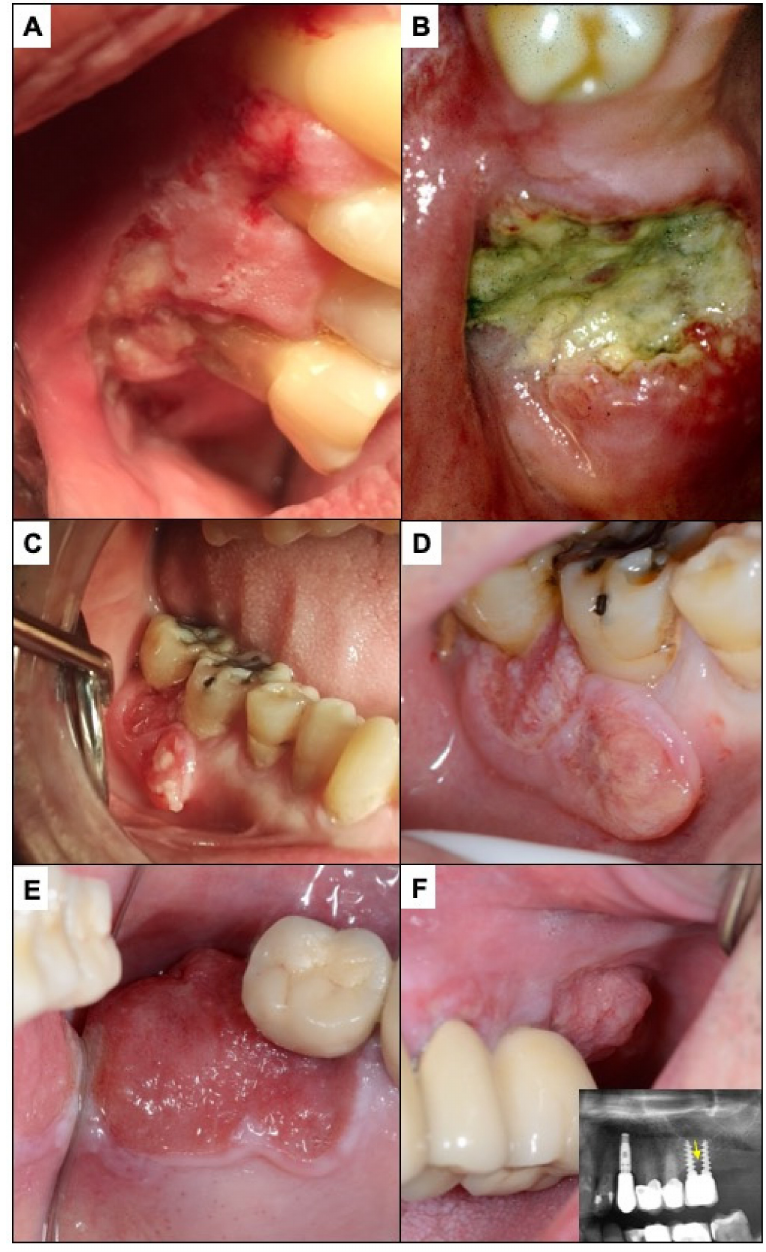
Figure 10. ( A ) The lesion presented by this patient was interpreted by the dentist as being consistent with periodontal disease; the biopsy showed that it was an oral carcinoma. ( B ) In the patient in the image, the neoplastic lesion located around the molar was interpreted as secondary to a periodontal process (periodontal disease). The dentist decided to extract the tooth and approximately 2 months later referred the patient for consultation due to a lack of healing of the extraction. ( C ) The carcinoma surrounding the lower right first and second molars in this patient was attributed by a private general practitioner general dentist to an infectious process affecting these molars and consequently the patient was treated with an antibiotic. Some time later the progressive growth of this neoplastic lesion was verified, where probably a worsening of the prognosis had already occurred ( D ). ( E ) corresponds to incipient carcinoma around an implant-supported upper molar. ( F ) shows how a mass with an evident neoplastic aspect is growing on the posterior part of the molar. This tumor lesion whose diagnosis has been delayed infiltrated the maxillary bone supporting the implants (radiographic image), which places this tumor in a T4 stage with a poor